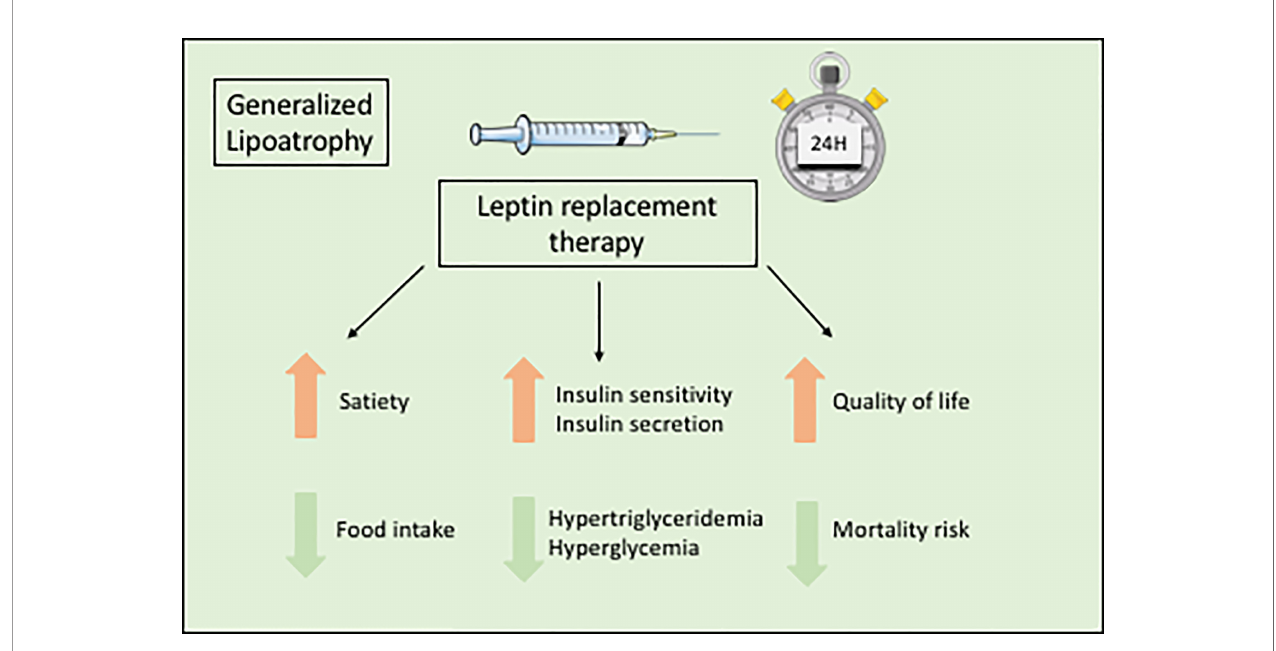
FIGURE 5 | Bene fi ts of metreleptin replacement therapy in generalized